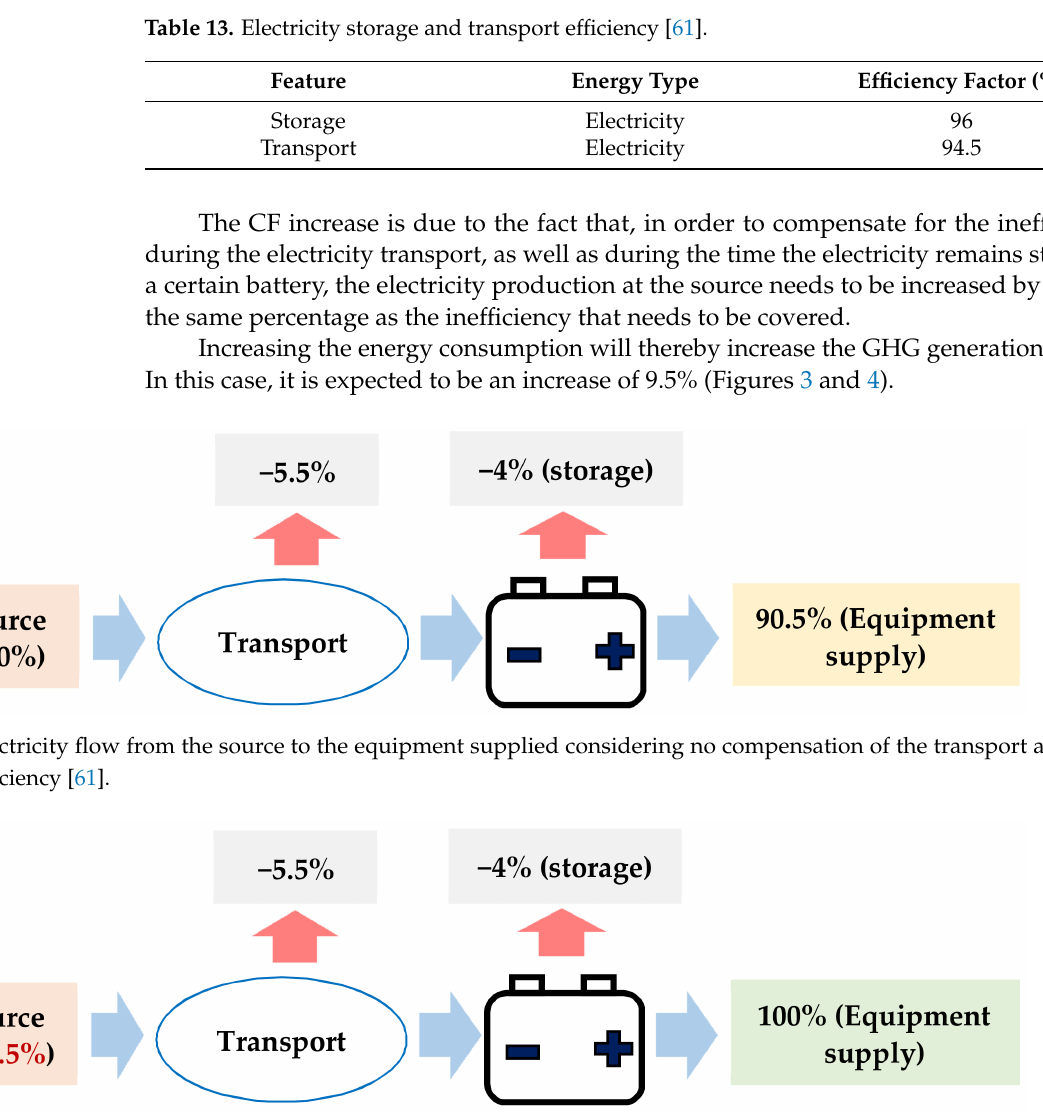
Figure 4. Electricity flow from the source to the equipment supplied considering overproduction at the source node to compensate for the transport and storage inefficiency